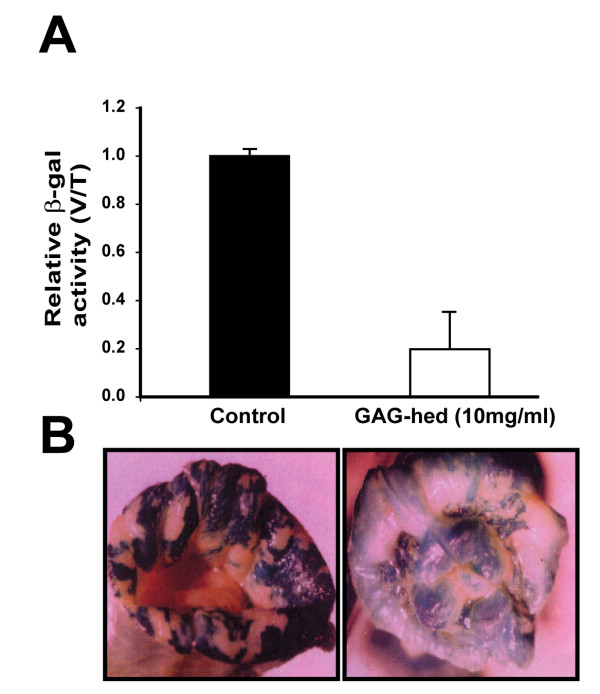
GAG-hed down-regulates the HPV18 LCR activity in transgenic mice. Female transgenic mice were used to test GAG-hed effects on the expression of lacZ reporter gene whose transcription is driven by HPV18-LCR. GAG-hed vaginal washes (10 mg/ml, 50μl) were applied twice a day for 6 days. Six vaginal and tongue specimens were stained or tested for β-galactosidase activity. (A) Relative activity is expressed as the relationship between β-galactosidase units in vaginal (V) and tongue (T) tissues (3 mice) for the unique concentration employed compared with the effects of saline application (3 mice). (B) Images obtained from vaginal samples stained for β-galactosidase using X-Gal. Left panel, vaginal sample treated with saline solution (control); right panel, vagina treated with GAG-hed.